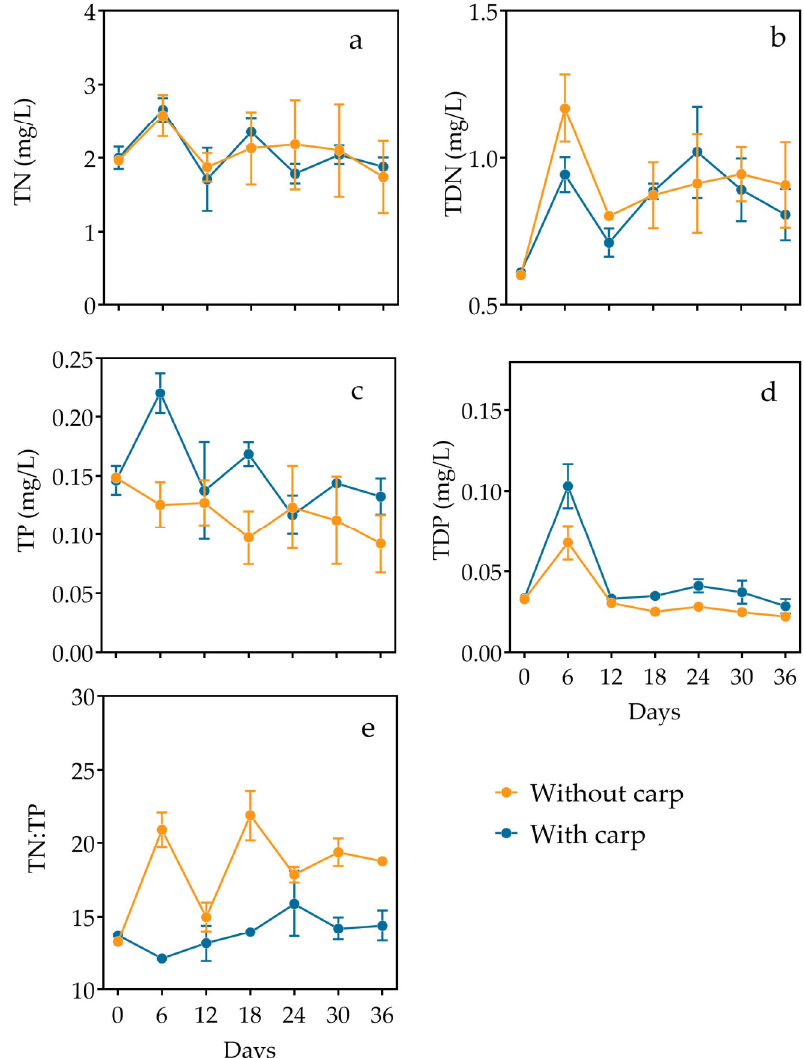
Figure 1. Comparisons of concentrations in water of ( a ) total nitrogen (TN), ( b ) total dissolved nitrogen (TDN), ( c ) total phosphorus (TP), ( d ) total dissolved phosphorus (TDP), and ( e ) TN to TP ratios between the two treatments. Values denote mean ± SE ( n = 3).